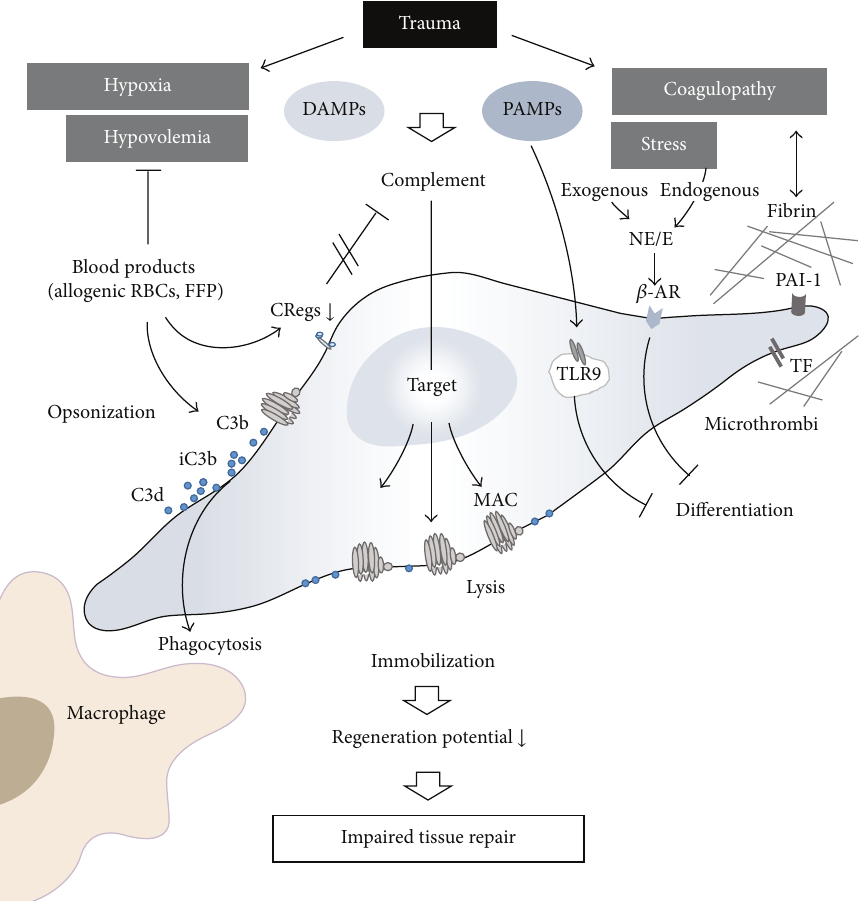
Figure 2: MSCs also function as targets of pathophysiological processes after trauma, leading to complement opsonization and macrophage phagocytosis and reduction in differentiation potential or ability to migrate to the site of injury and finally resulting in the impairment of regenerative potential and tissue repair. See text for detailed information. CRegs: complement regulatory proteins; DAMPs: damage- associated molecular patterns; FFP: fresh frozen plasma; MAC: membrane attack complex; NE/E: norepinephrine/epinephrine; 𝛽 -AR: beta- adrenergic receptor; PAI-1: plasminogen activator inhibitor 1; PAMPs: pathogen-associated molecular patterns; RBC: red blood cells; TF: tissue factor; TLR9: toll-like receptor